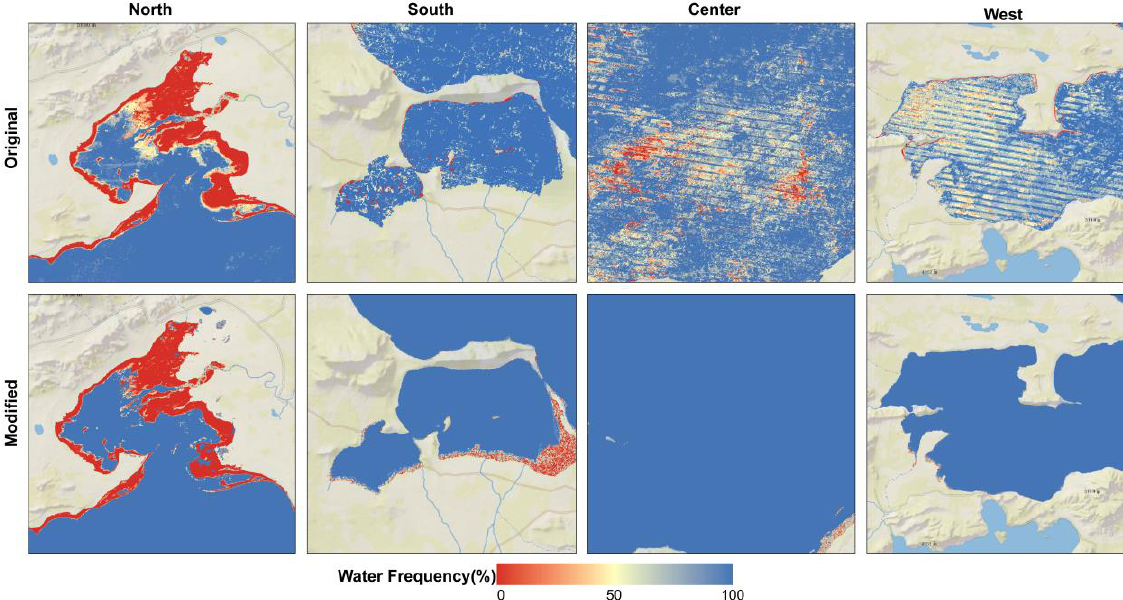
Figure 6. Results of the detailed reconstructed data.